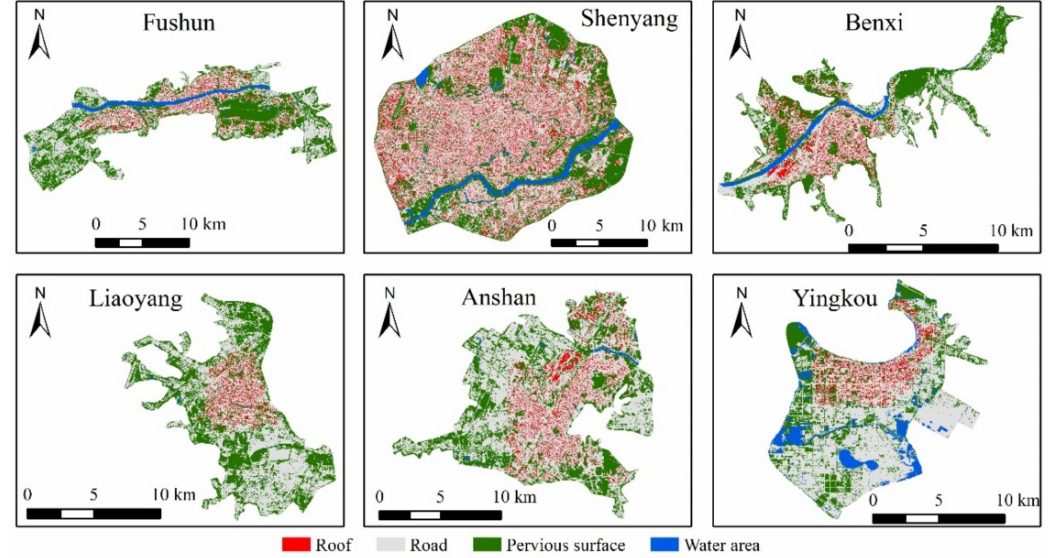
Figure 3. The underlying surfaces of the six